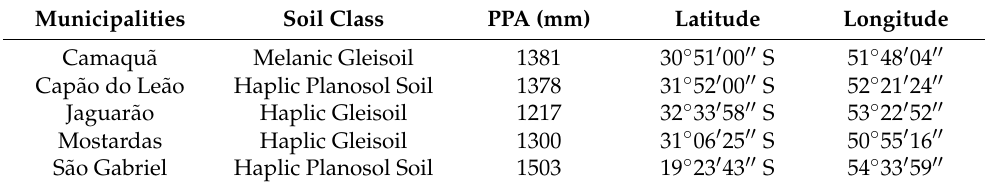
Table 2. Soil classification, annual rainfall (PPA), latitude and longitude of the validation areas of Azospirillum brasilense in Rio Grande do Sul.